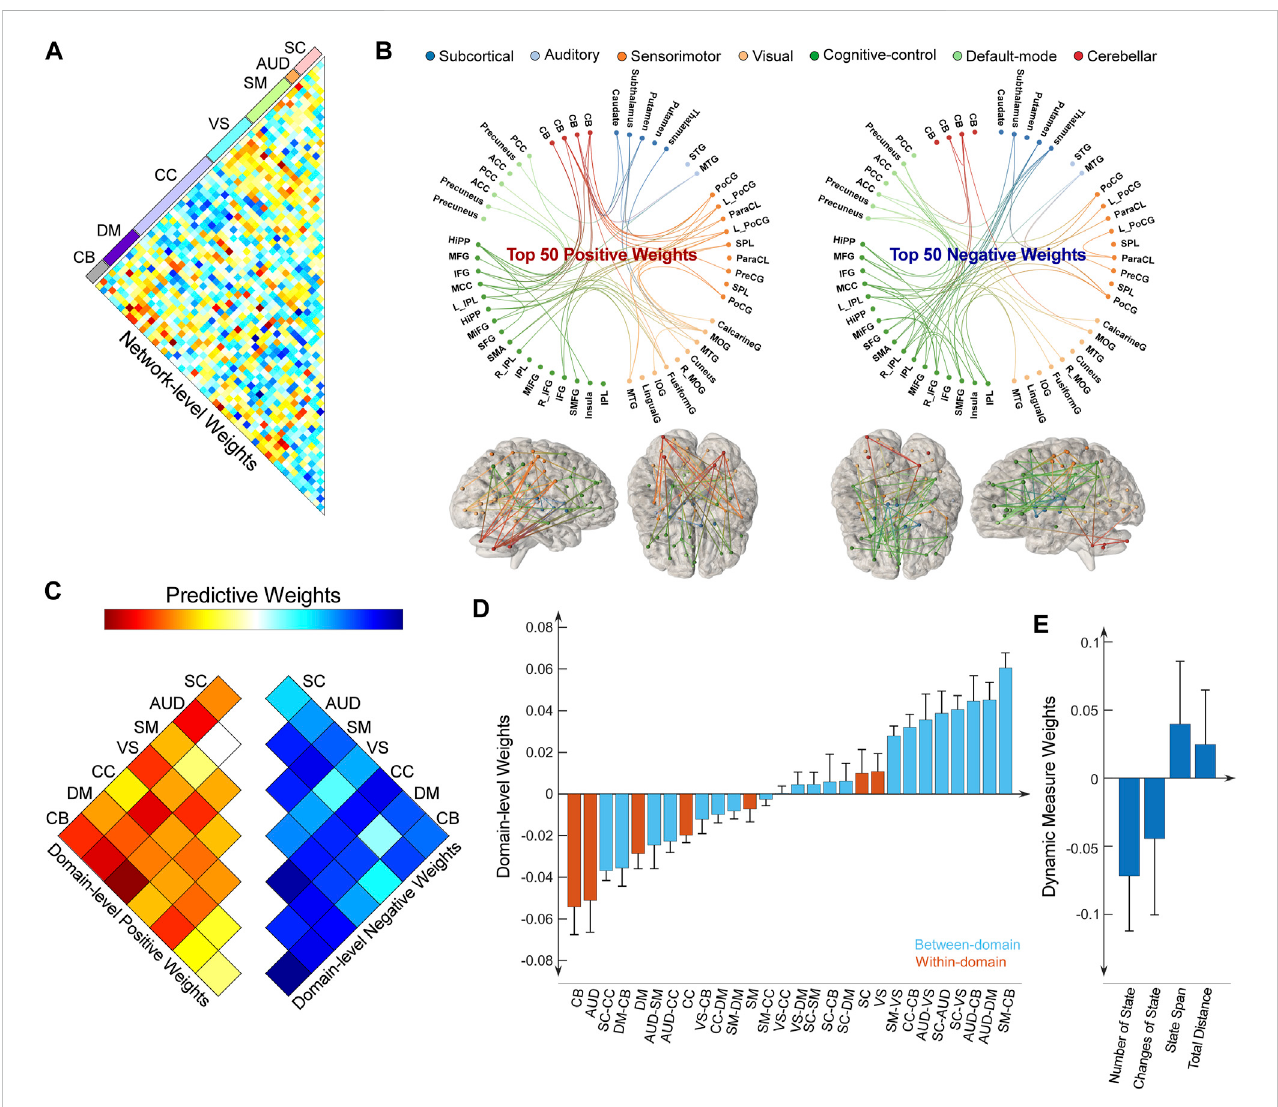
FIGURE 5 Distributions of weight maps in predicting cognitive changes (HVLT-DR score). (A) Distributions of raw predictive weights at the FNC pair level averaged across 10,000 CV rounds. (B) Functional connectome plots with the top 50 positive weights and top 50 negative weights. ICNs are arranged into seven functional domains with different colors. (C) The cell plots show the domain-level representation of the predictive weights. For each pair of domains (between-domain and within-domain), we averaged predictiveweights of all sFNCbelonging to that domainpair. Positive weights and negative weights were separately summarized for each domain pair to demonstrate their relative contribution. (D) Mean weights distribution of within-domain and between- domain sFNC in the predictive models. Error bars indicate standard deviation. (E) Mean weights distribution of dFNC features in the predictive